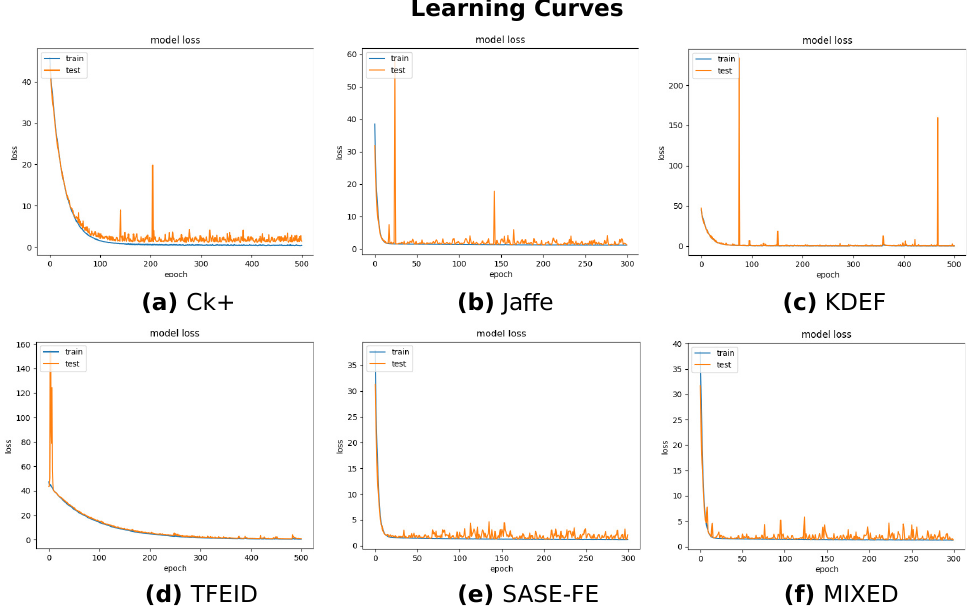
Figure 7. Learning Curves (Loss) over the examined